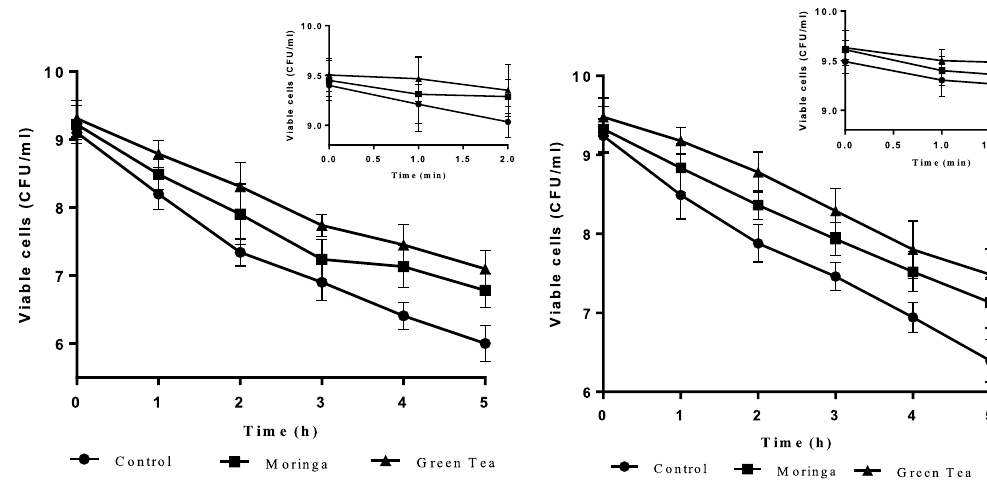
Fig. 1. Survival of control encapsulatedprobioticcells (CC) and novel encapsulatedprobioticcells (NC) with herbalextracts L. plantarum DSM 20205upon sequential exposure to simulated salivary fluid (SSF) for 2 min, simulatedgastric fluid (SGF) for 2 h and simulated intestinal fluid (SIF) for 3 h. The insetrepresents the survival of cells when exposed in SSF for 2 min.